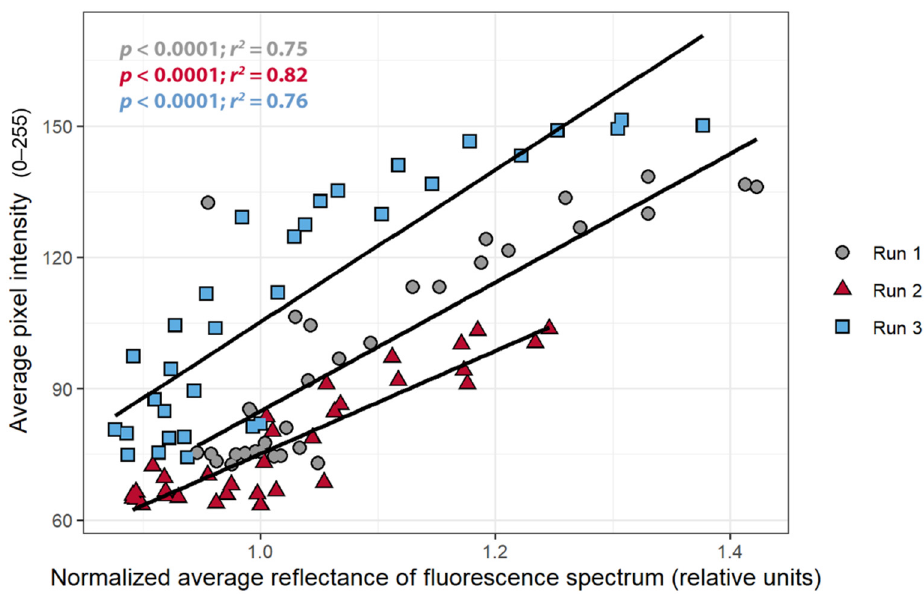
Figure 6. The relationship between normalized average reflectance of fluorescence spectrum and the average pixel intensity of Catharanthus roseus treated with atrazine. The average pixel intensity was taken from the chlorophyll fluorescence images in a 50 × 50 area near the spot of the reflectance measurements.